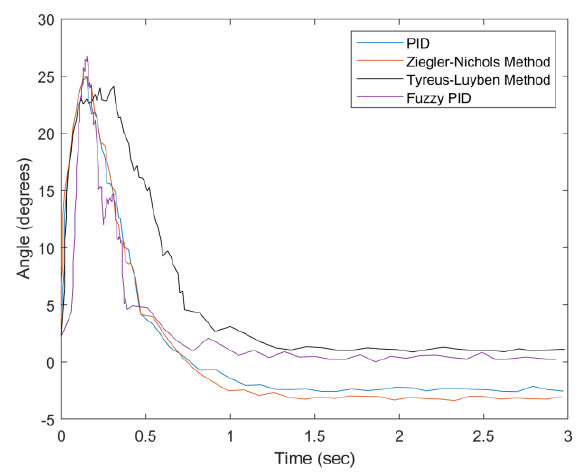
Figure 31. Convergence of angle with weight = 100 g.